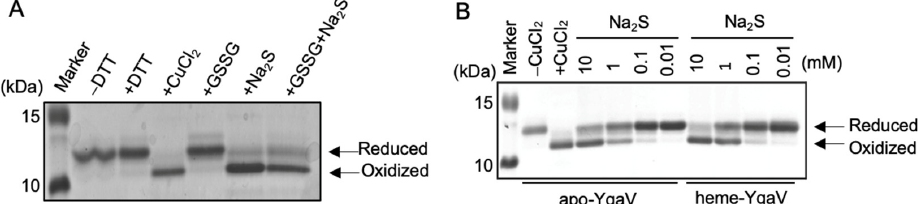
Figure 4. Mobility shifts of YgaV caused by thiol modification on SDS ‐ PAGE gels: ( A ) The purified apo ‐ YgaV was treated with 1 mM DTT, 0.5 mM CuCl 2 , 1 mM GSSG, and/or 10 mM Na 2 S. The proteins were precipitated by trichloroacetic acid (TCA) treatment, labeled with AMS, and then applied for SDS ‐ PAGE; ( B ) The AMS modification was performed with apo ‐ and heme ‐ reconstituted YgaV with different concentrations of Na 2 S. The apo ‐ YgaV was also treated with 0.5 mM CuCl 2 as a control. Proteins were stained with Coomassie brilliant blue.